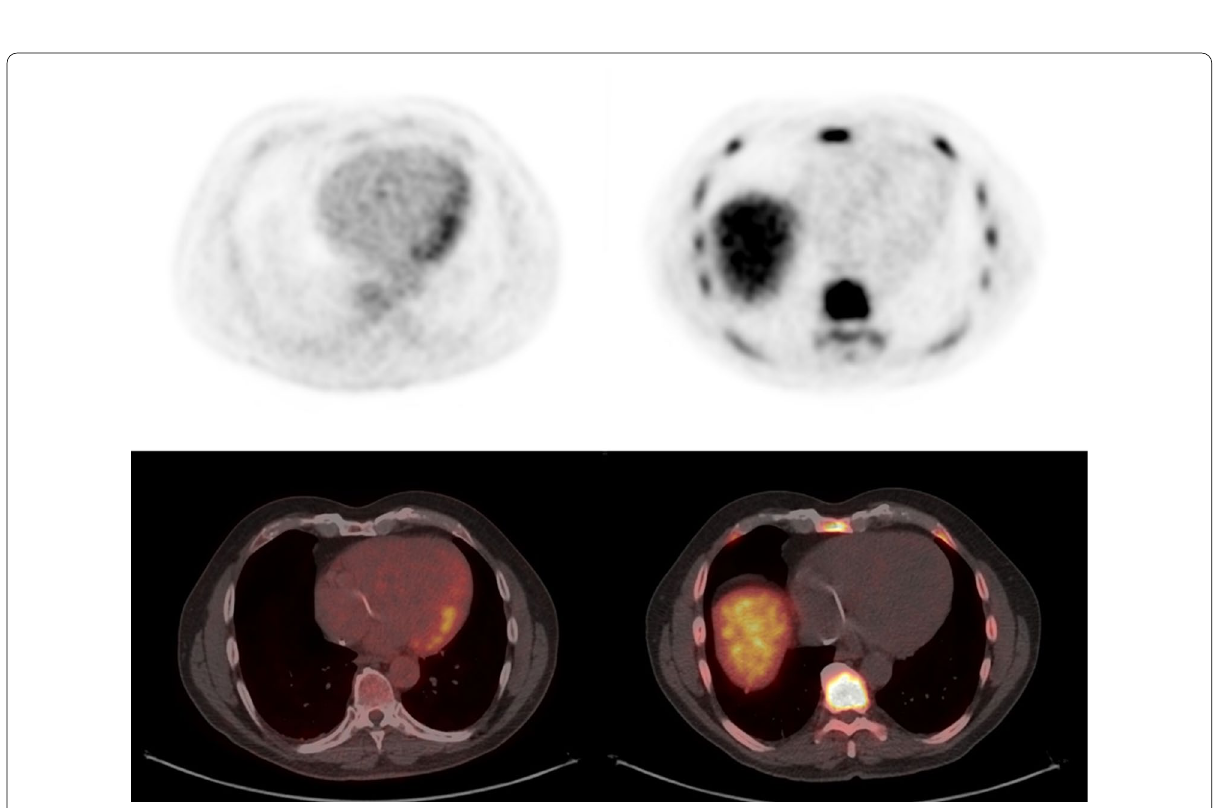
Fig. 6 Subject demonstrating isolated diffuse lateral ventricular wall FDG uptake (left), a finding usually interpreted as a normal variant. No corresponding uptake was present on the FLT study